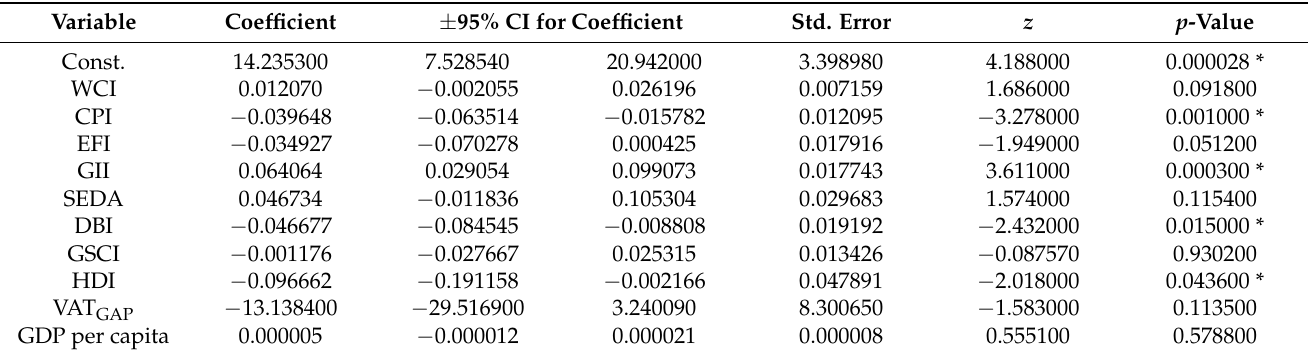
Table 3. The regression coefficients estimation of random effects model for the Basel AML index within EU destination